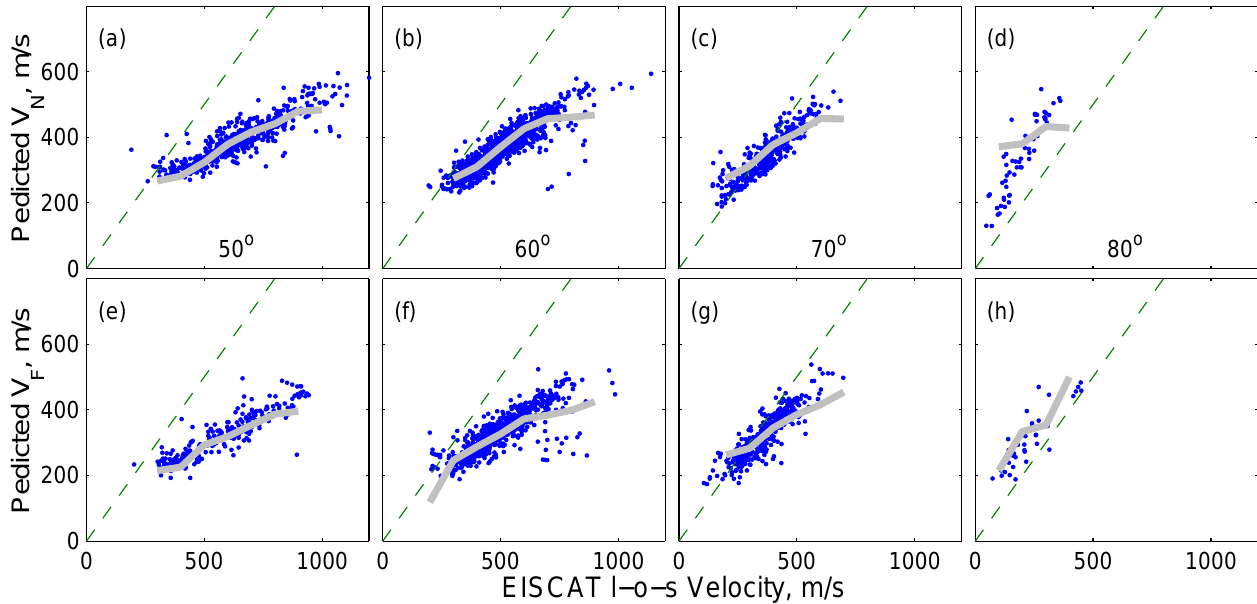
Fig. 6. (a–d) and (e–h) blue points are the predicted velocities, i.e. A N , F C s cos 2 60 ( cos 2/ cos h 2 60 i ) n magnitudes, versus of the EISCAT l-o-s electron drift velocity, V los , grey solid lines, are the mean STARE velocities taken from Fig. 3, for more details see text. E × B